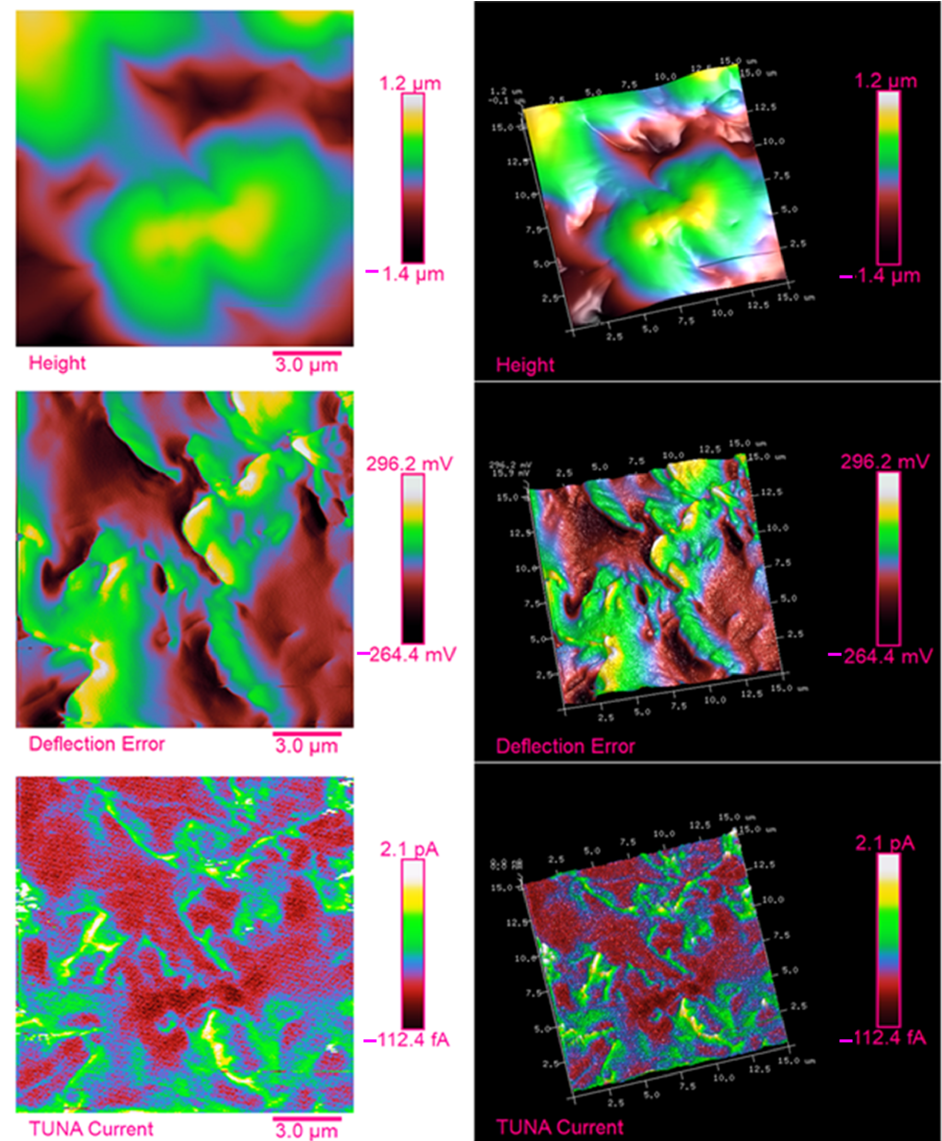
Figure 10. Two-dimensional (on the left ) and three-dimensional (on the right ) TUNA pictures of the EM+5%G+0.5%CNF sample. In order to estimate the CNF dispersion in the resin, Figure 11 shows the shape of the current changes visible in green, red and blue colors (see on the right) associated with the three white lines in the TUNA current image (see on the left) of the EM+5%G+0.5%CNF sample. We can see a good distribution of the carbon nanofibers within the host matrix. This can be deduced from the fact that the frequency of the changes due to filler/matrix interchanges along the three lines is quite constant, even if we can observe some areas of the sample where the current variations seem greater in correspondence with more con- ductive electricity.